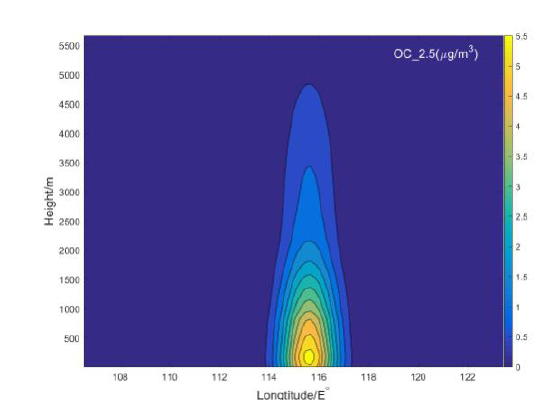
Figure 2 Mass concentrations distribution vertically of the No.2